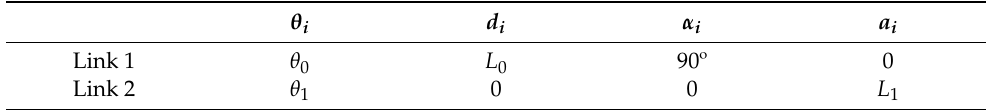
Figure 5. Schematic used to calculate the kinematics of the system along with the reference axes employed. Table 1. Denavit–Hartenberg parameters of the